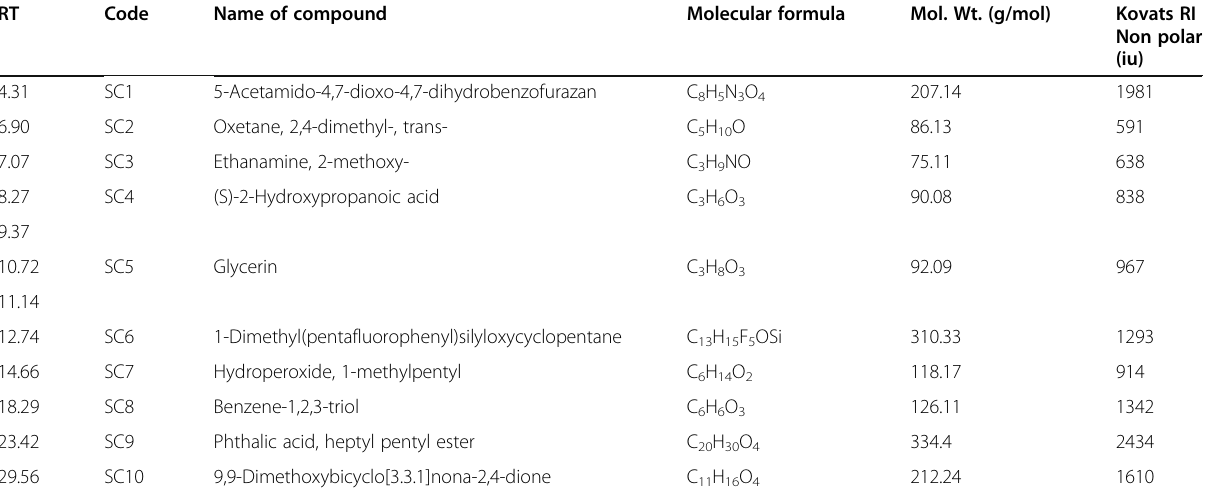
Table 1 Compounds identified in the GCMS analysis of methanol extract of fermented Syzygium cumini seeds RT Code Name of compound Molecular